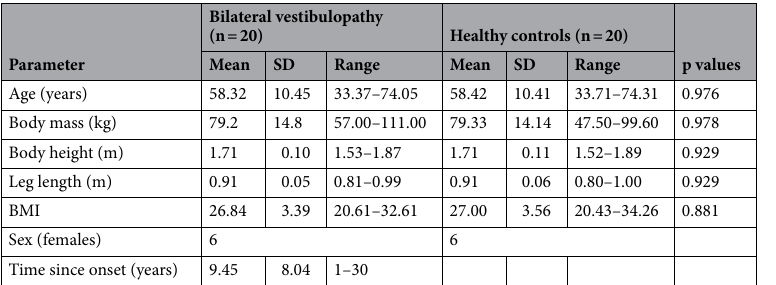
Table 1. Descriptive data of the study sample including mean ages and anthropomorphic characteristics. N = number of subjects; kg = Kilograms; m = metre. p-values are calculated using a 2-sample t test.